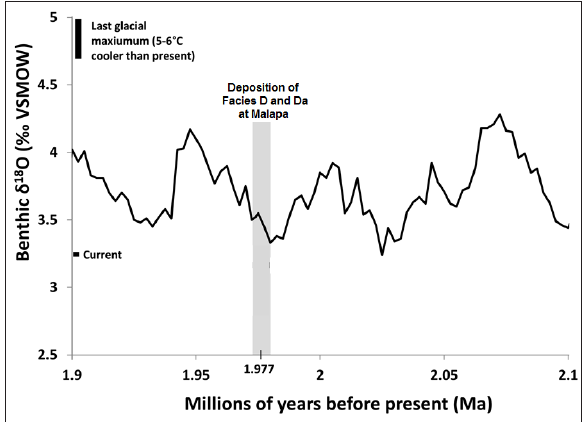
Figure 4: Change in benthic δ 18 O during the dated Malapa time period. The benthic δ 18 O stack of 57 globally distributed sites by Lisiecki and Raymo 37 shows that changes in average ocean temperature are cyclical, and could indicate global oceanic or atmospheric cooling during the Malapa sample time